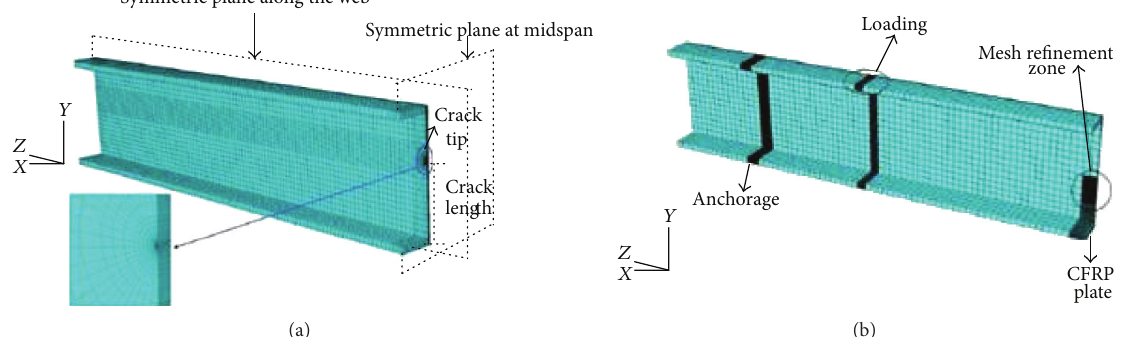
Figure 4: (a) A geometrical model using ABAQUS in the FE analysis and (b) the mesh refinement around the loading, anchorage, and crack zones